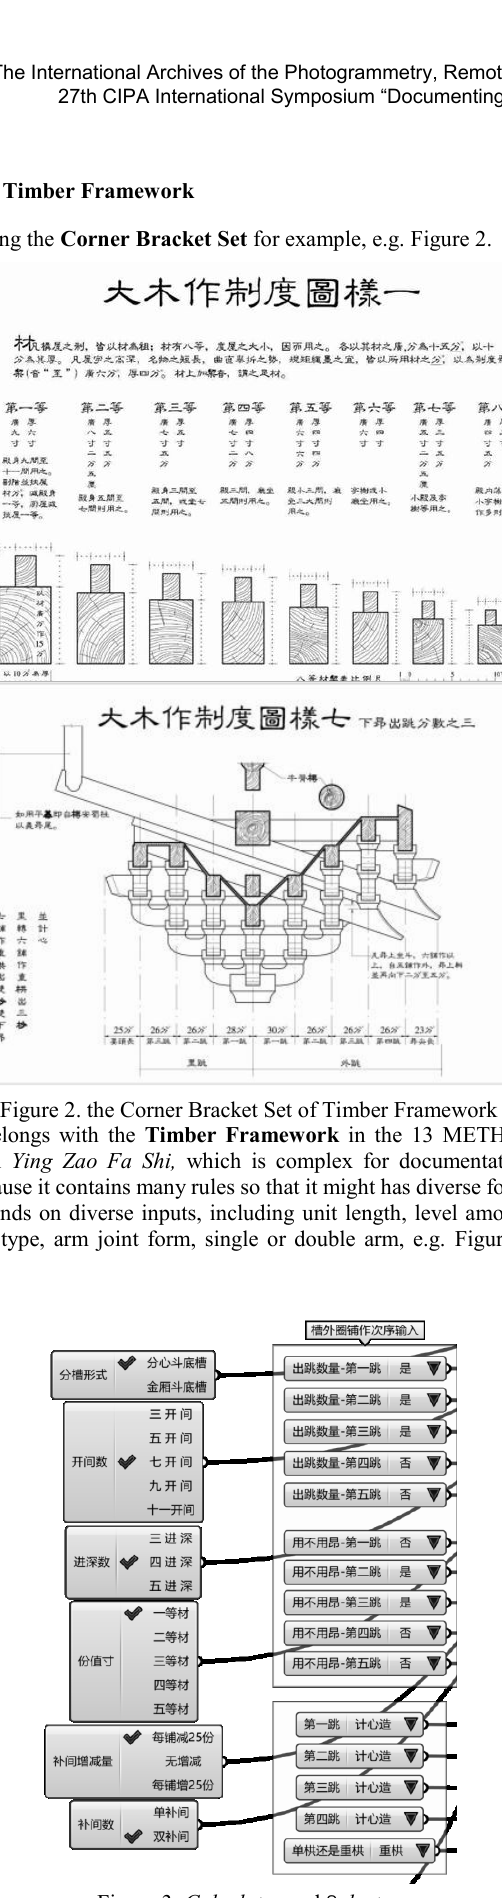
Figure 3. Calculator and S elector